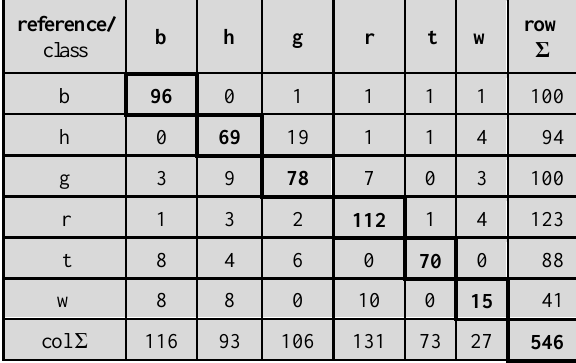
Table 10. Error matrix at cross validation (DT classification)